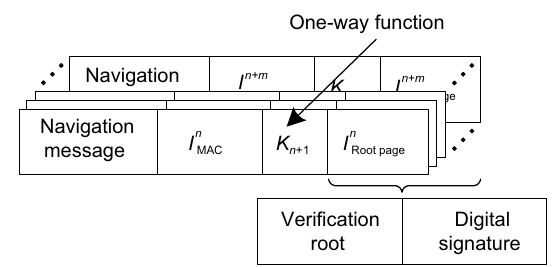
Fig. 2 Message in typical NMA schemes consists of navigation messages, Message Authentication Codes (MACs) I n MAC , keys in a delayed-disclosure one-way chain, and root information. Root page I n Root page consists of a verification root to verify keys and a digital signature to verify the verification